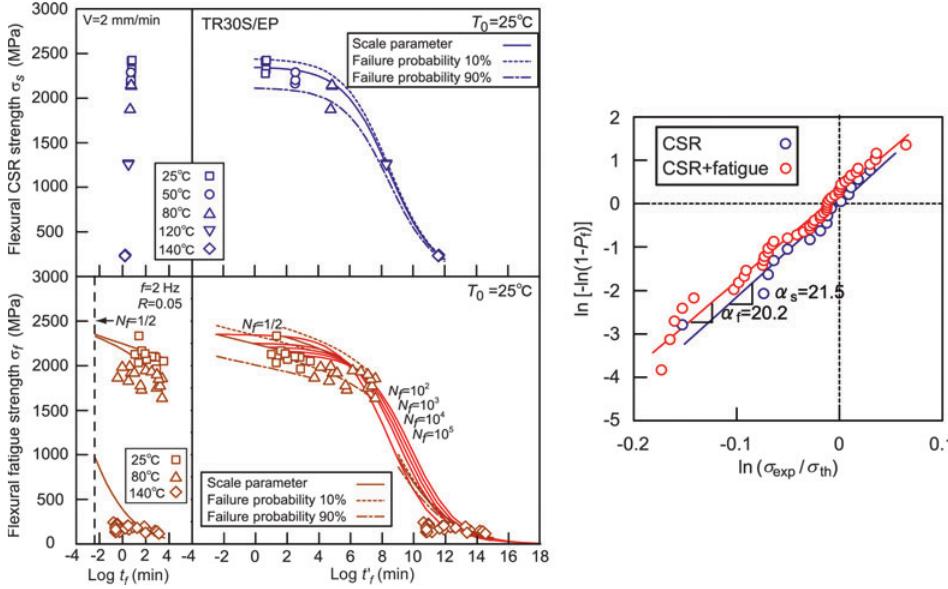
Figure 17 Flexural CSR (blue) and fatigue (red) strengths master curves for TR30S carbon fi ber and epoxy resin with Weibull parameters (data generated by Miyano).